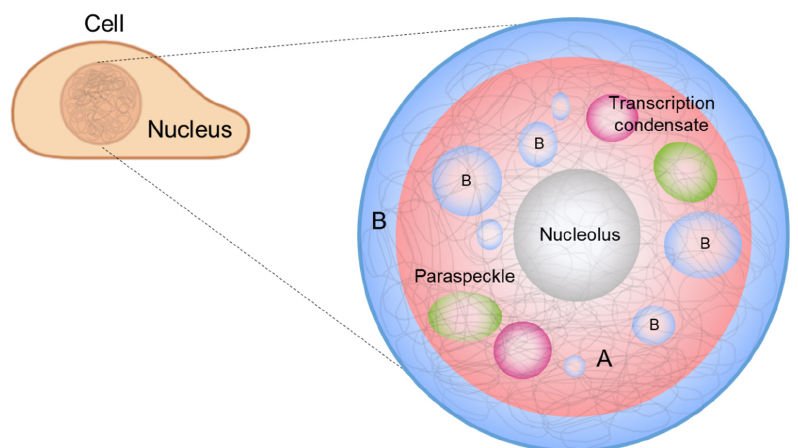
Figure 1. Biomolecular condensates in the nucleus: A and B compartments, nucleolus, paraspeckles, and transcriptional condensates. Chromosomes are largely segregated via phase separation into two compartments: euchromatin (A, red) and heterochromatin (B, blue). Phase separation is also involved in the formation and regulation of membraneless organelles such as the nucleolus (gray), transcription condensates (magenta), and paraspeckles (green) in the nucleus.